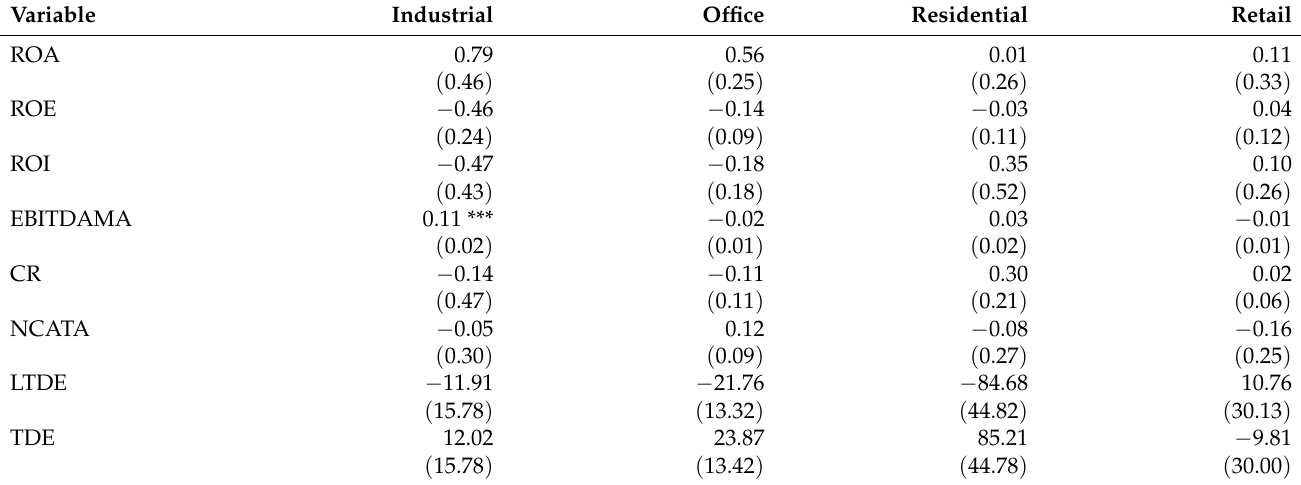
Table 6. Model Result—Specification